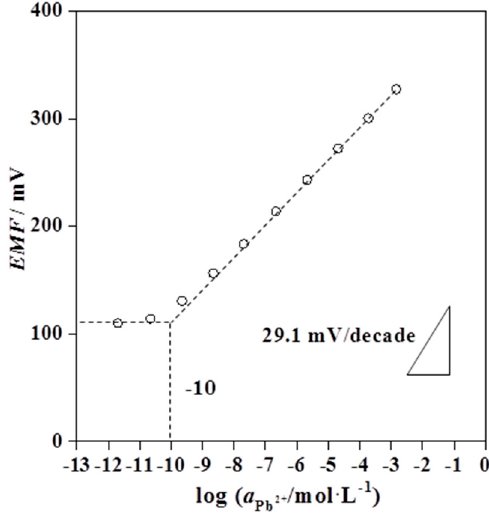
Figure 3. Potentiometric calibration curve of the multi-walled carbon nanotube (MWCNTs)-based plasticizer-free solid-contact Pb 2 + -selective electrodes in Pb 2 + concentration range from 2.0 × 10 − 12 to 1.5 × 10 − 3 mol · L − 1 .